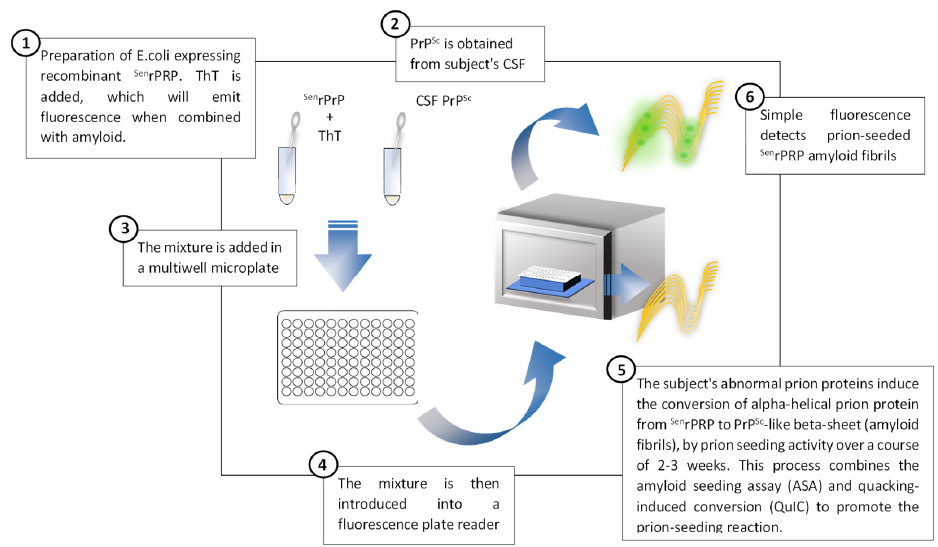
Figure 4. Description of the prion real-time quaking-induced conversion technique applied to the diagnosis of prion diseases, adapted from Orrù et al., 2017 [86].